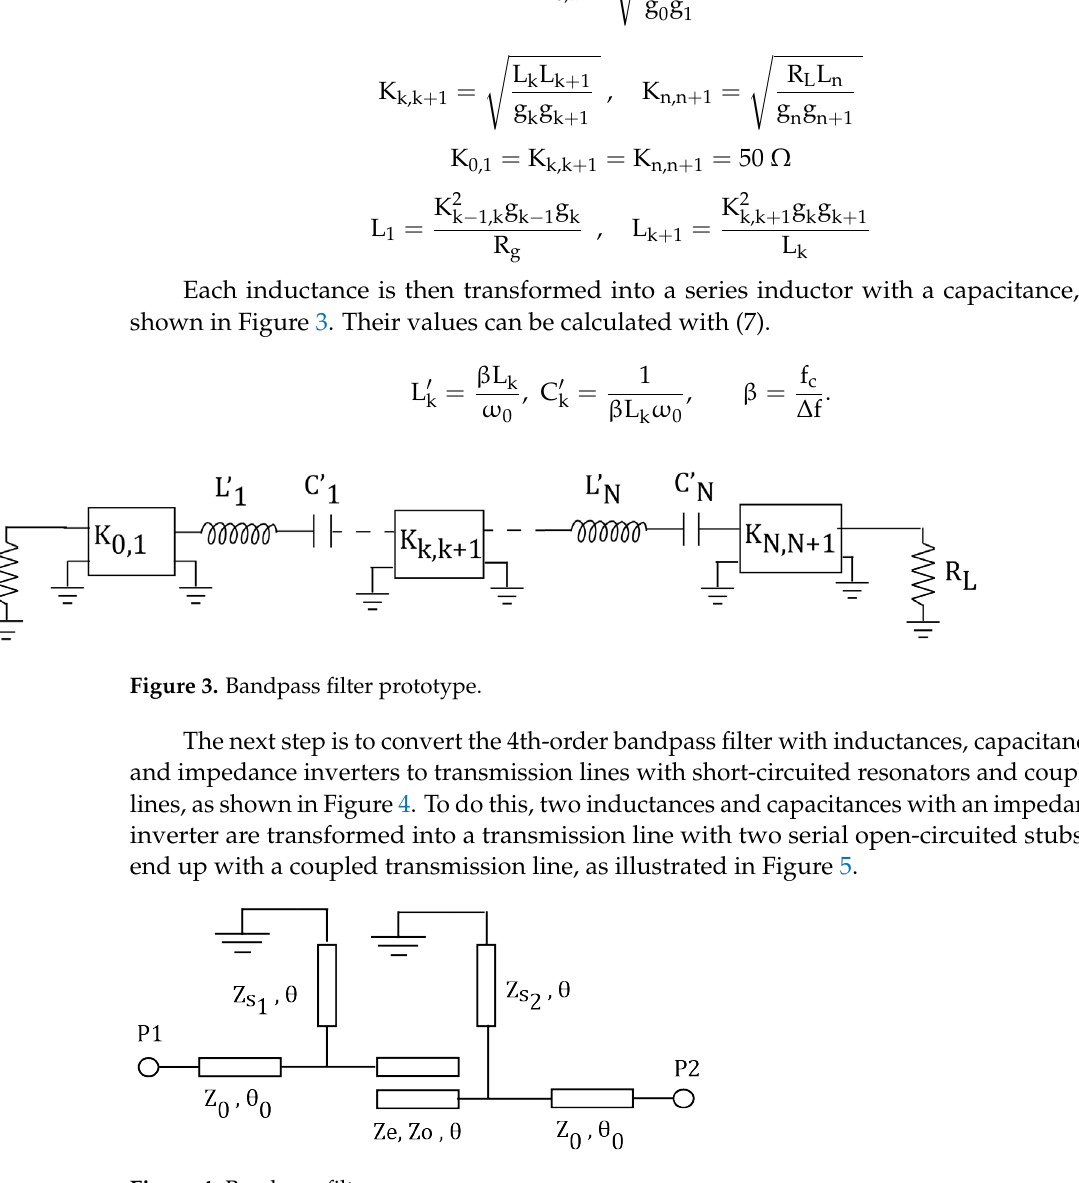
Figure 4. Bandpass filter. Figure 4. Bandpass